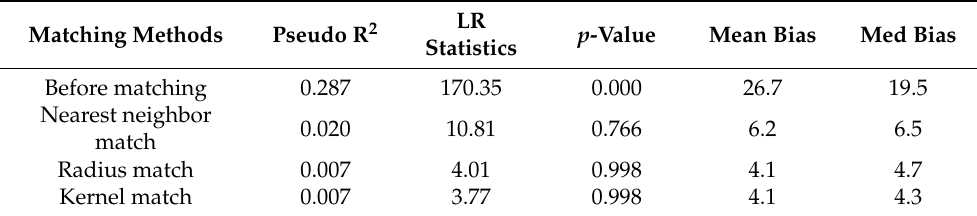
Figure 2. The co-support domains of substitute group and non-substitution group before matching ( left ) and after matching ( right ). Table 5. Balance test results of explanatory variables before and after matching under different matching methods.